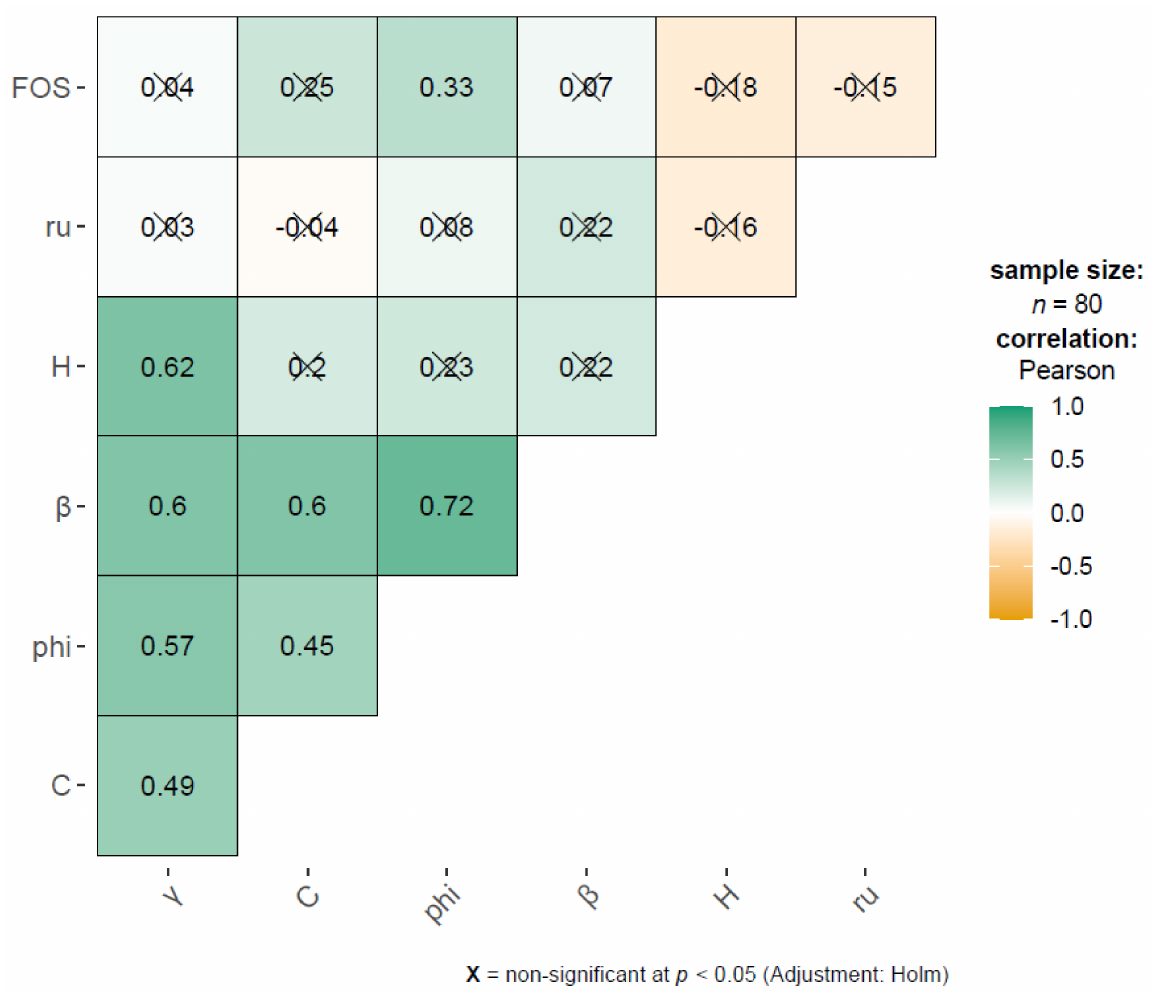
Figure 4. Correlation matrix (aka correlalogram) plot of slope data.